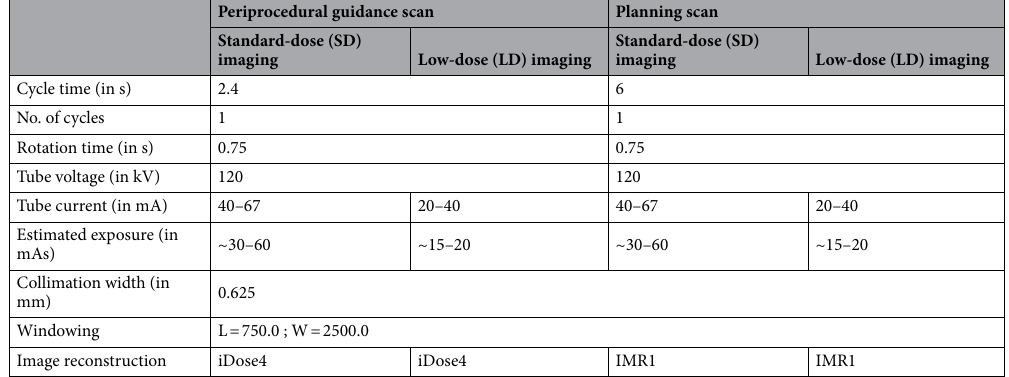
Table 1. Details of the scanning protocol and image reconstruction for the planning and periprocedural guidance scans using a standard-dose (SD) and low-dose (LD)